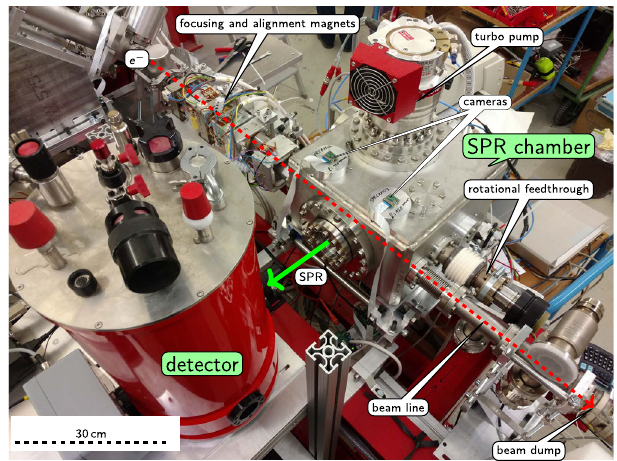
FIG. 7. Setup to detect SPR. The electron beam passes several magnets and is guided through the SPR chamber, in which the drum shown in Fig. 6 is mounted. The detector is placed directly in front of the vacuum